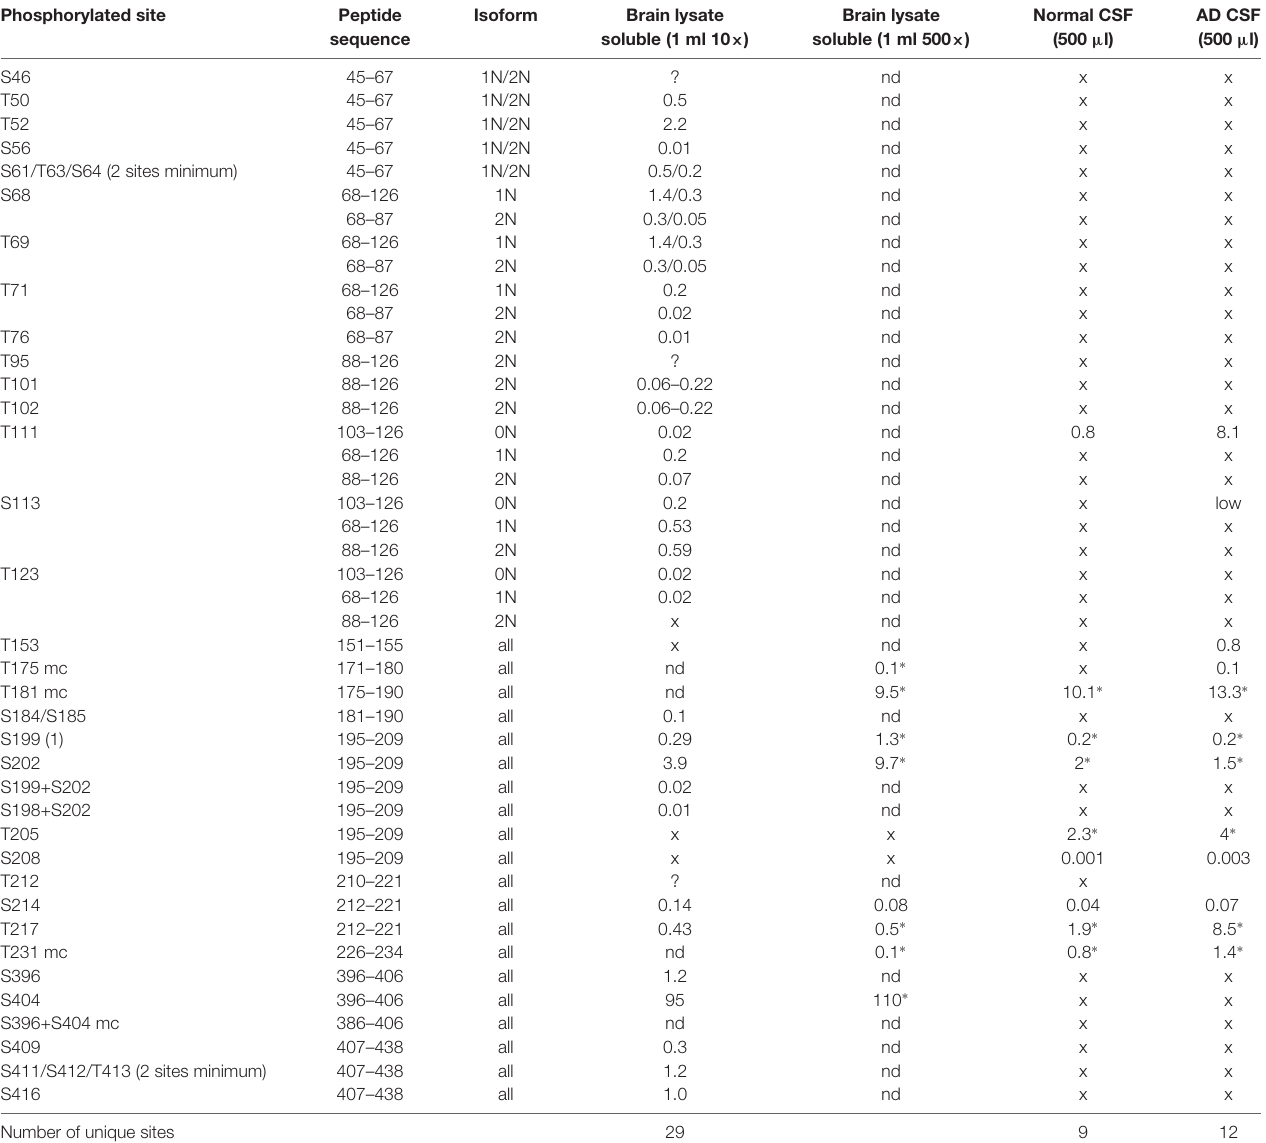
TABLE 1 | Brain/cerebrospinal fluid (CSF) pool phosphorylation rate comparison (HJ8.5+Tau1 IP-MS). Phosphorylated